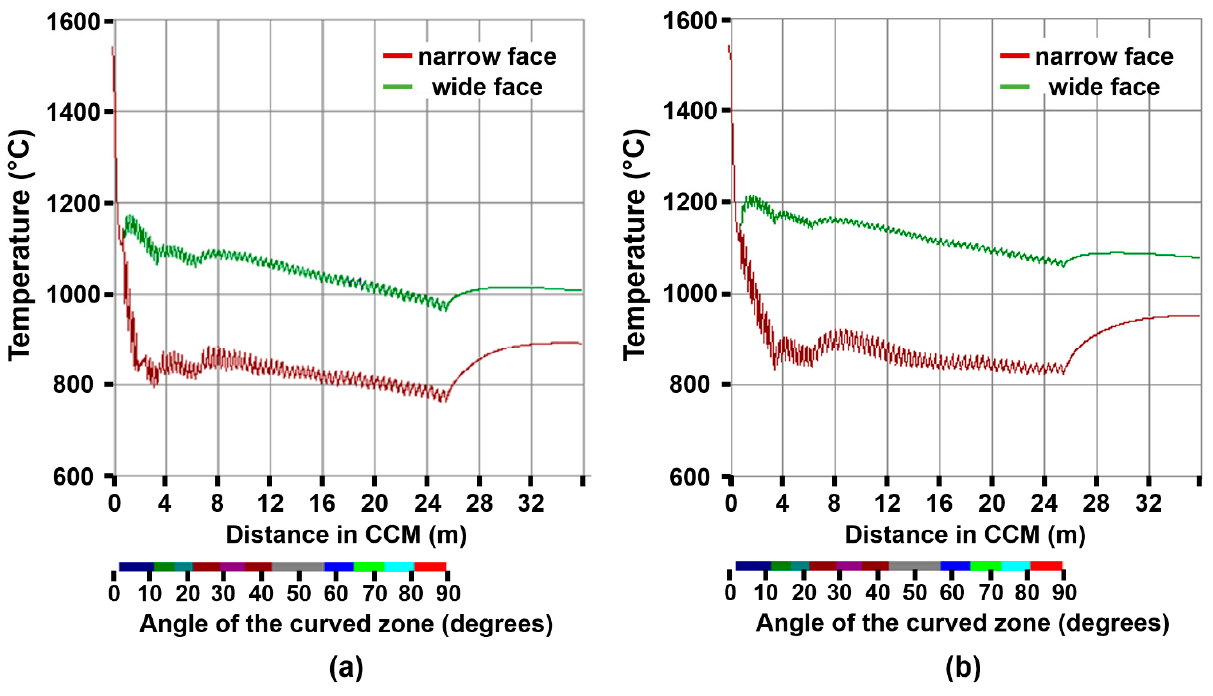
Figure 17. Surface temperatures on the narrow and wide slab faces ( a ) for a casting speed = 1.0 m/min and ( b ) 1.30 m/min. Table 9. Calculated errors for the simulated billets, case 1.